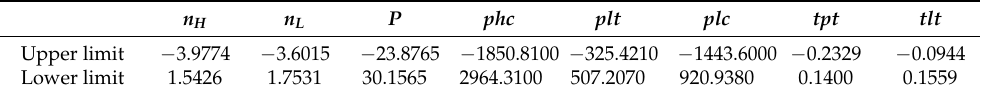
Figure 12. Boxplot of residuals in training set. Table 3. Detection threshold of normal pattern group.